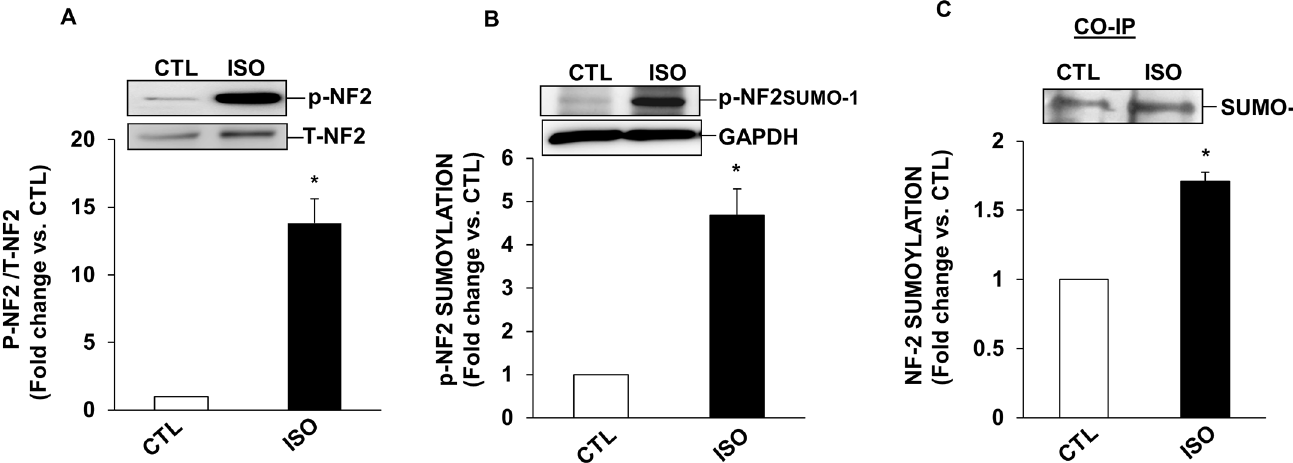
Fig 1. β -AR stimulation induces post-translational modifications of NF2 in ARVMs. ARVMs were treated with ISO (10 μM) for 15 mins. Total cell lysates were analyzed by western blot using phospho-specific anti-NF2 antibodies. This antibody recognized ~70 kDa (phosphorylated NF2; A) and ~100 kDa (phosphorylated and sumoylated NF2; B) proteins. The lower panels exhibit the mean data normalized to total NF-2 (T-NF2) or GAPDH, (cid:3) p < 0.05 vs CTL; n = 3–7. (C) To confirm NF2 sumoylation, cell lysates were immunoprecipitated with anti-NF2 antibodies. Immunoprecipitates were analyzed by western blot using anti-SUMO-1 antibodies. Panel C exhibits quantitative increase in NF2 sumoylation in response to ISO. (cid:3) p < 0.05 vs CTL; n = 3.